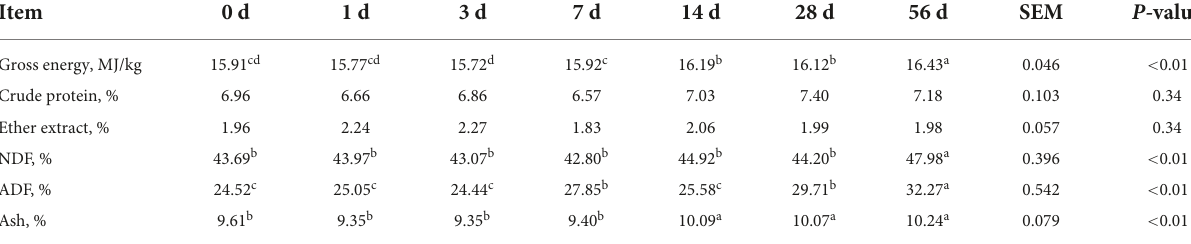
LAB, lactic acid bacteria; FM, fresh matter; ND, not detected; “–,” default; SEM, standard error of means; propionate and butyrate were not detected in this study. a − e Means in the same rowfollowedbydifferentsuperscriptlettersdiffer( P < 0.05). TABLE 2 Dynamic changes of nutrient component of sorghum stalk silage during ensiling process.